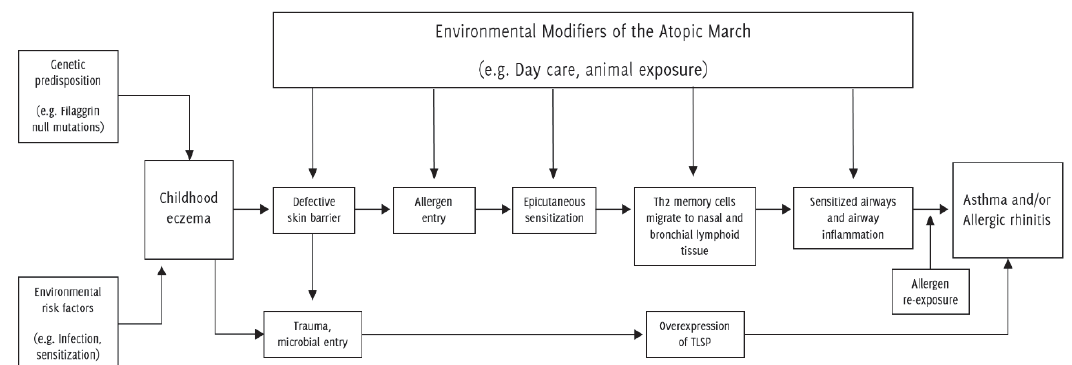
Figure 1. A proposed pathway to explain the atopic march from childhood eczema to the development of asthma and allergic rhinitis. 4